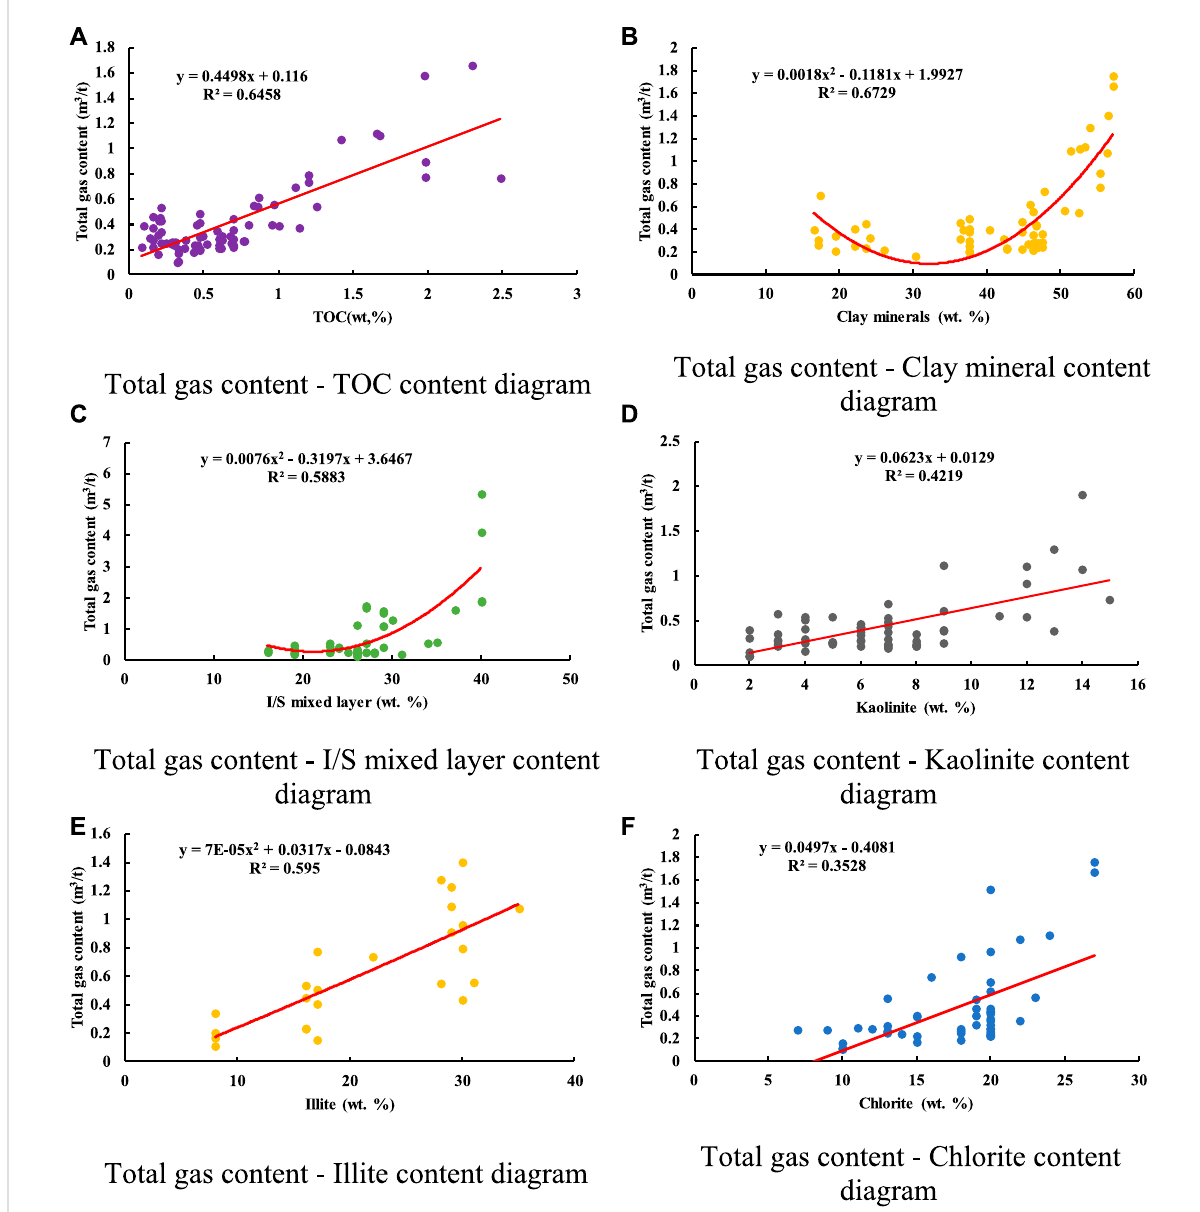
FIGURE 6 Correlation analysisoftotalgascontentinshaleandshalematerialcomposition,LianggaoshanFormationshaleinWellTYX.SeeFigure1forthe well